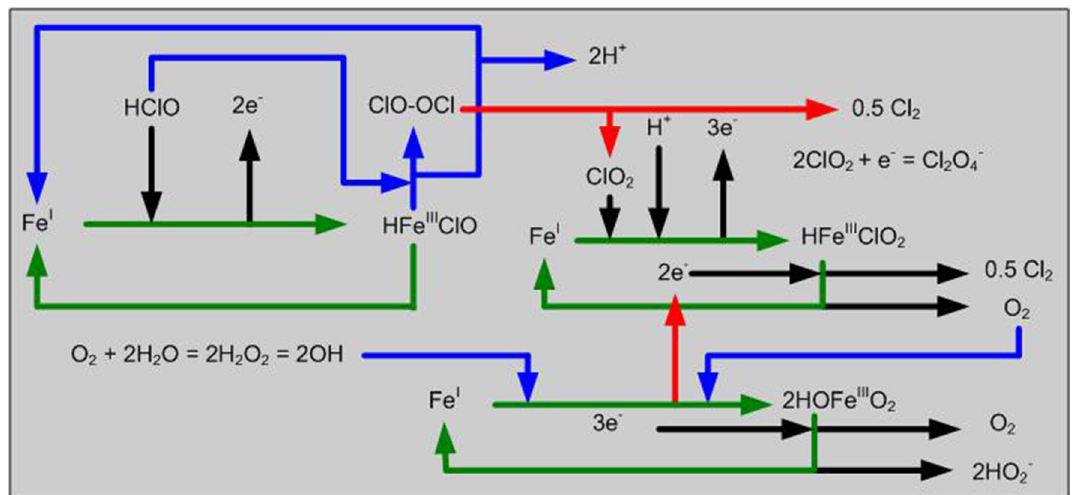
Cl O − 2 4 reaction is from